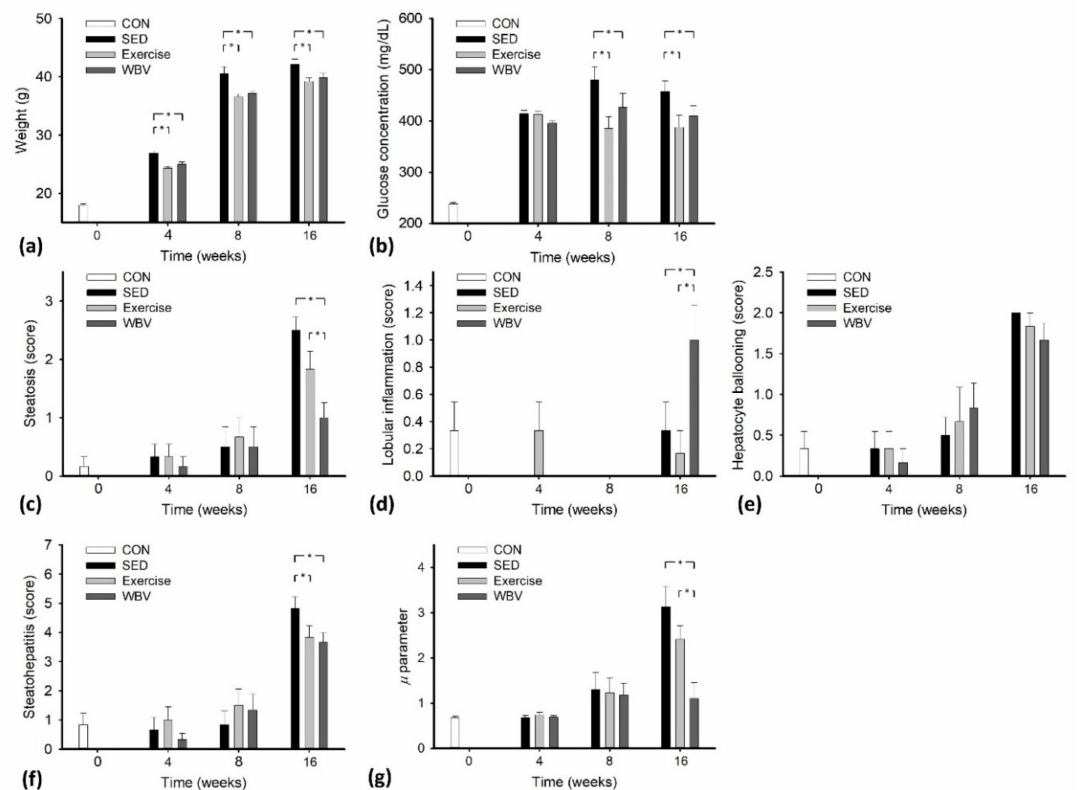
Figure 4. Changes in MetS, histopathological, and ultrasound examination results across the inter- vention periods. ( a ) Body weight, ( b ) glucose concentration, ( c ) steatosis, ( d ) lobular inflammation, ( e ) hepatocyte ballooning, ( f ) steatohepatitis, and ( g ) HK µ parameter (* p <